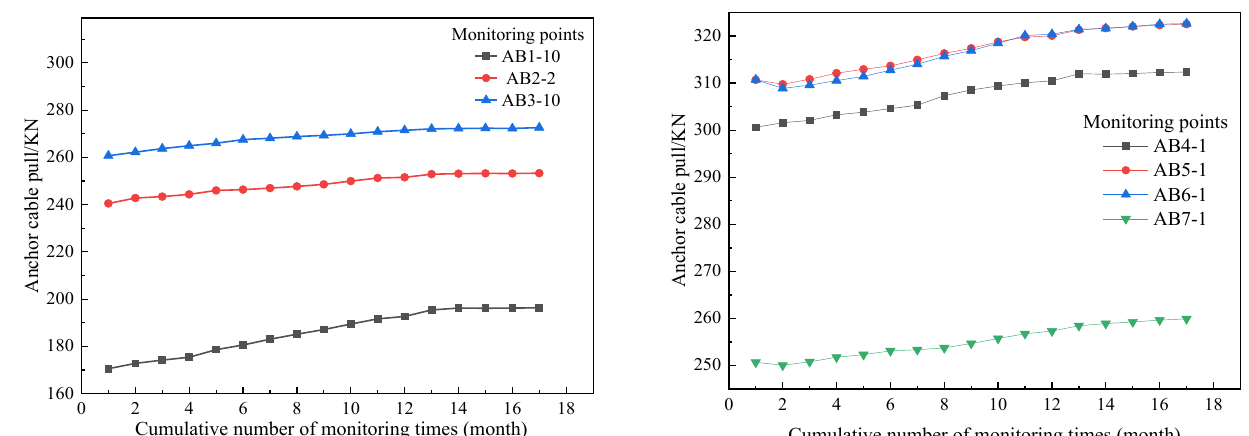
Figure 21. Anchor cable internal force monitoring